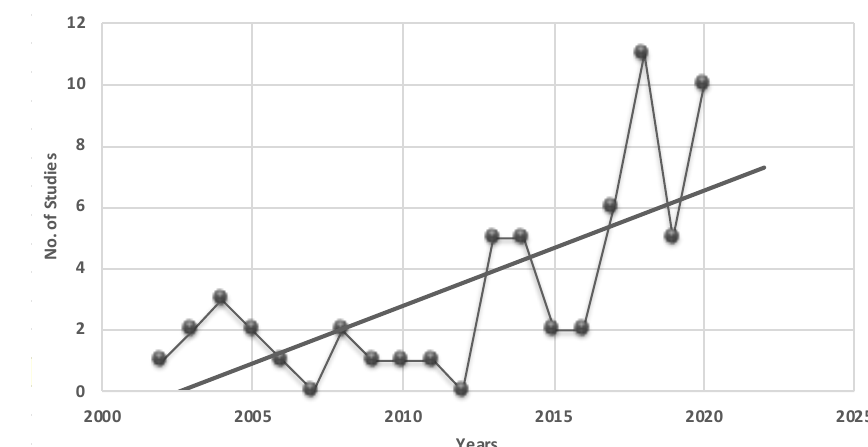
Figure 2. Number of studies published to date since